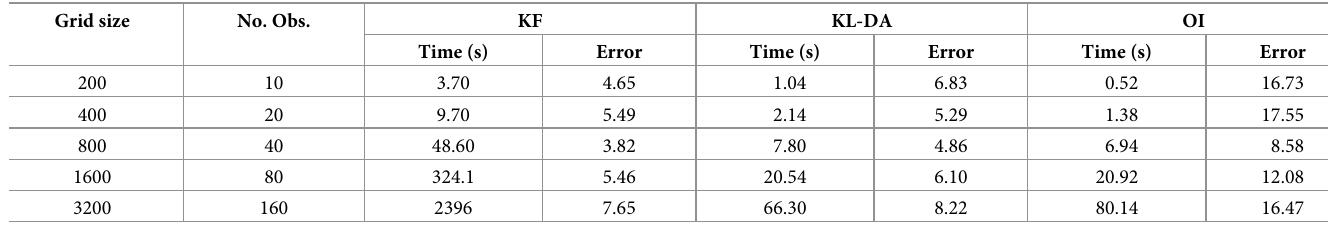
at the end of the simulation t = 600 depending on the size of the domain and 2